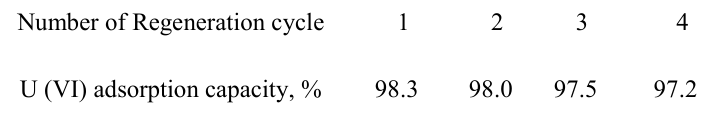
Table 6. The generation results of the exhausted